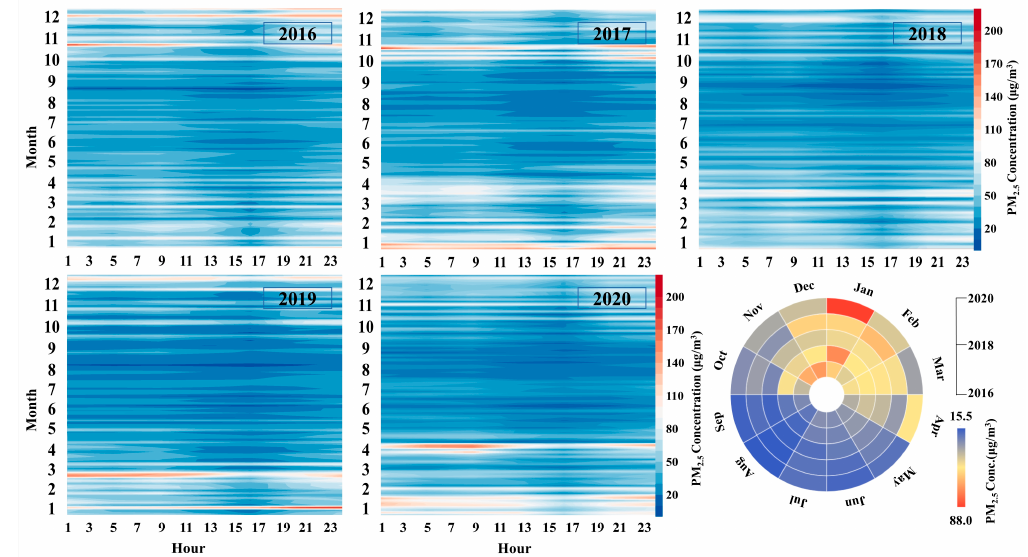
Figure 4. Time series of PM 2.5 concentration in Northeast China from 2016 to 2020. The stacked color graphs present the hourly mapping of PM 2.5 concentrations and the pie charts show the variation in monthly average PM 2.5 values.